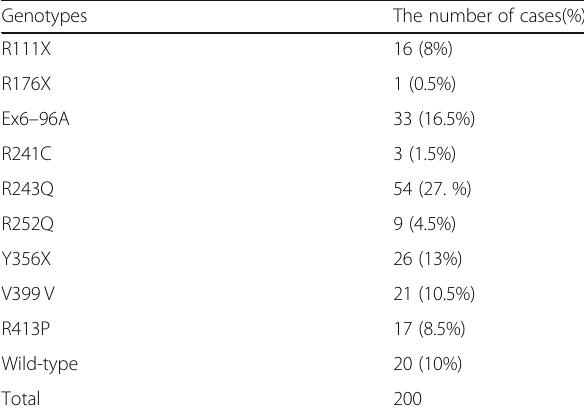
Table 4 The frequencies of different genotypes of PAH Genotypes